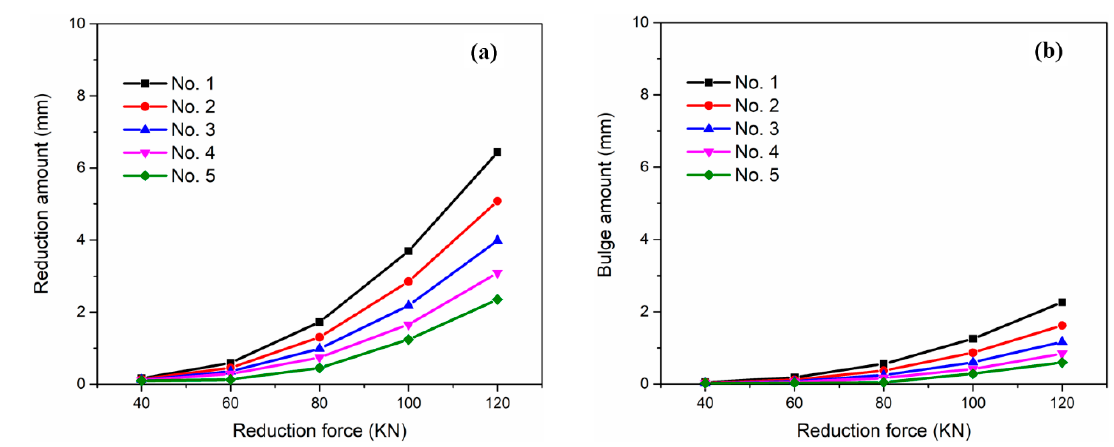
Figure 8. Deformation of round bloom after reduction ( a ) reduction amounts, ( b ) bulge amounts.